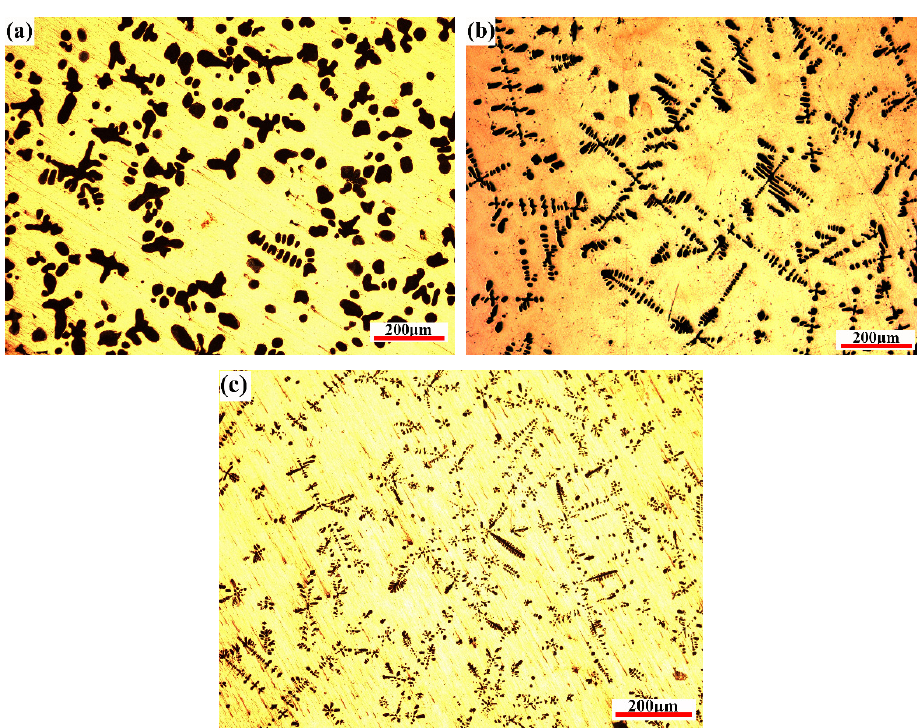
Figure 9. OM solidification microstructures under three different cooling rates: ( a ) 0.3 ◦ C/s, Figure 9. OM solidi fi cation microstructures under three di ff erent cooling rates: ( a ) 0.3 ( b ) 1.5 ◦ C/s, and ( c ) 5 ◦ C/s. °C/s, ( b ) 1.5 °C/s, and ( c ) 5 °C/s.